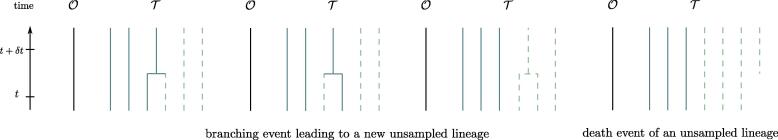
Four unobservable scenarios taken into account to derive the ODEs (3.2), (4.1).